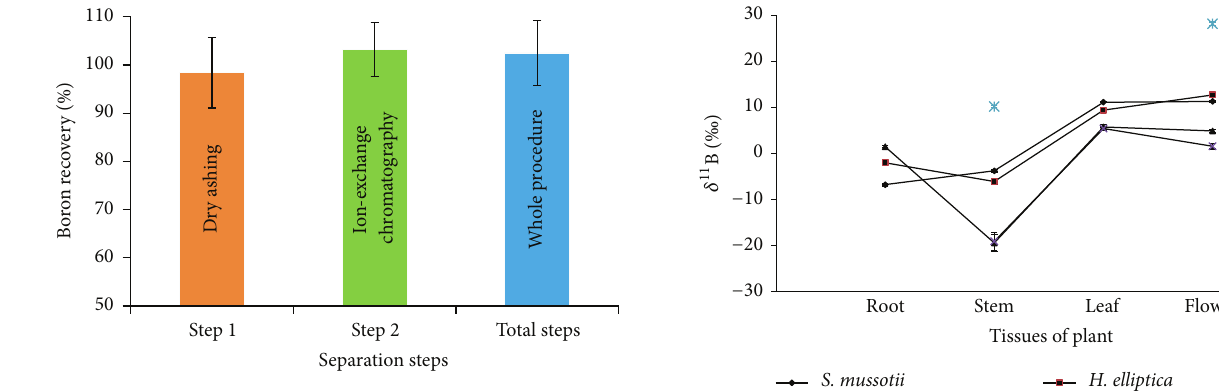
Figure 1: Recovery yields of B for the individual step and the entire procedure.